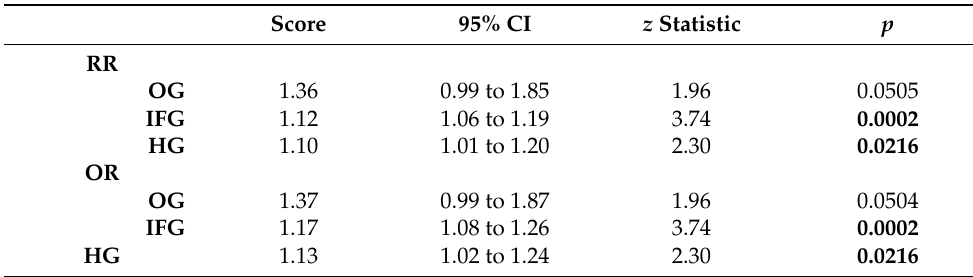
OG, hypoglycemia; NG, normoglycemia; IFG, impaired fasting glycemia; HG, hyperglycemia; N- Table 2. Risk assessment of elevated MLR. MLR, normal MLR; H-MLR, high MLR. Table 2. Risk assessment of elevated MLR.